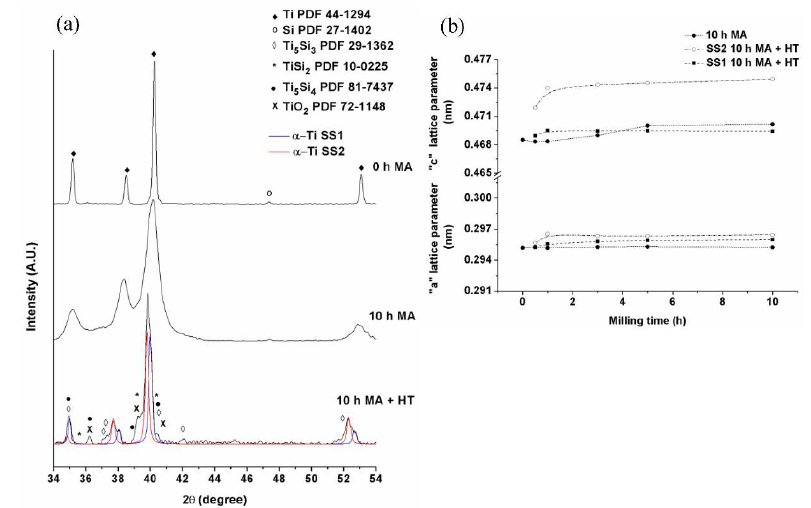
Figure 6. ( a ) XRD patterns of the mixture of powders without milling (0 h MA), milled during 10